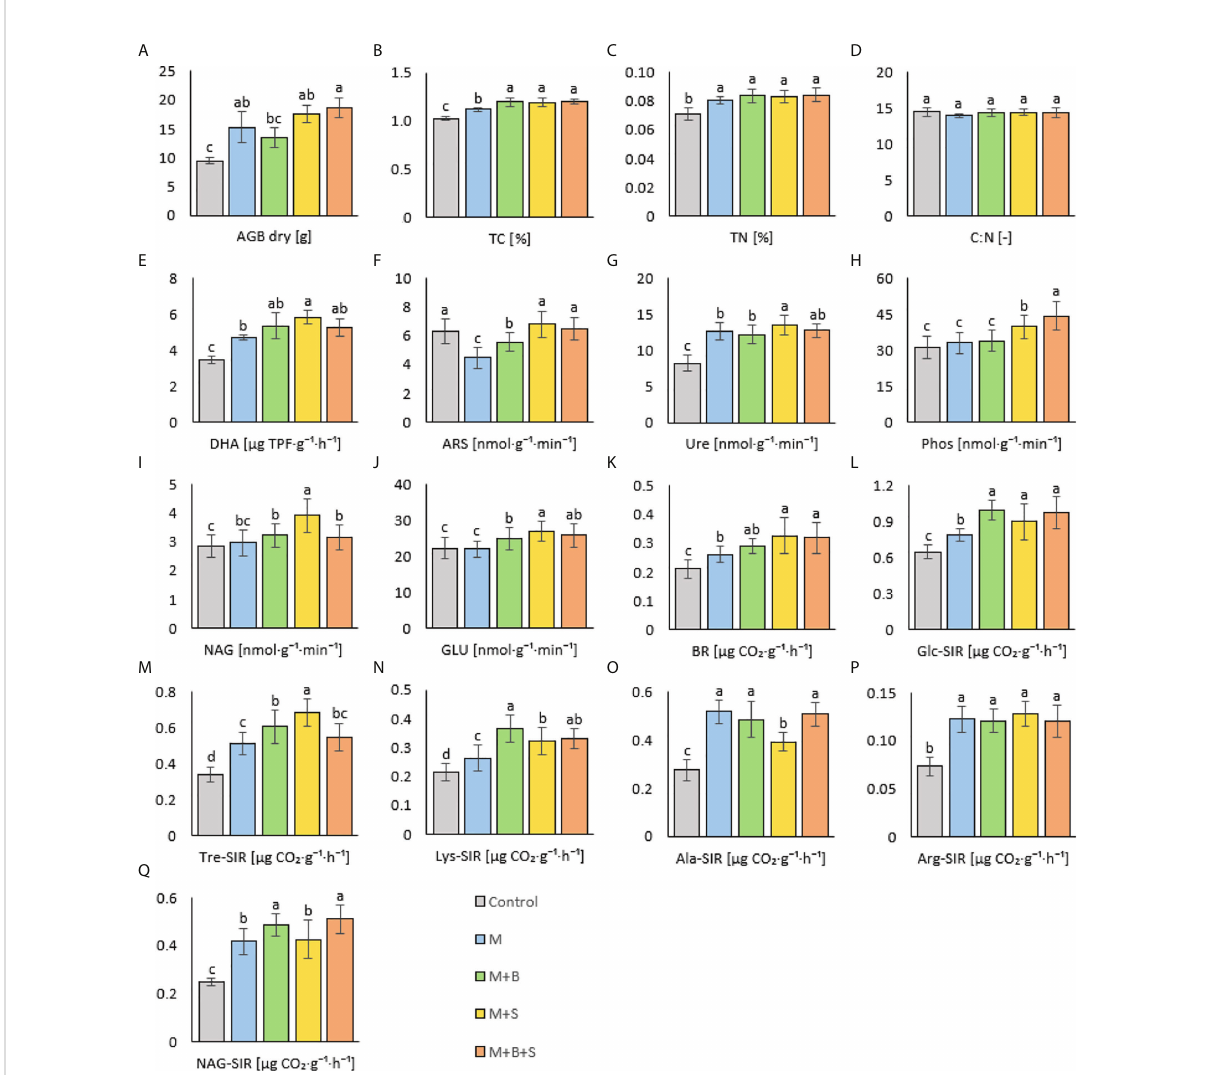
FIGURE 5 Dry plant above ground biomass and soil properties of variants amended with various manure types. (A) dry above ground biomass, (B) total carbon, (C) total nitrogen, (D) C:N ratio, (E) dehydrogenase activity, (F) arylsulfatase act., (G) urease act., (H) phosphatase act., (I) N-acetyl- b -D- glucosaminidase act., (J) b -glucosidase act., (K) basal respiration, (L) D-glucose-induced resp., (M) D-trehalose-induced resp., (N) L-lysine- induced resp., (O) L-alanine-induced resp., (P) L-arginine-induced resp., (Q) N-acetyl- b -D-glucosamine-induced resp. Different letters indicate differences at level of signi fi cance p ≤